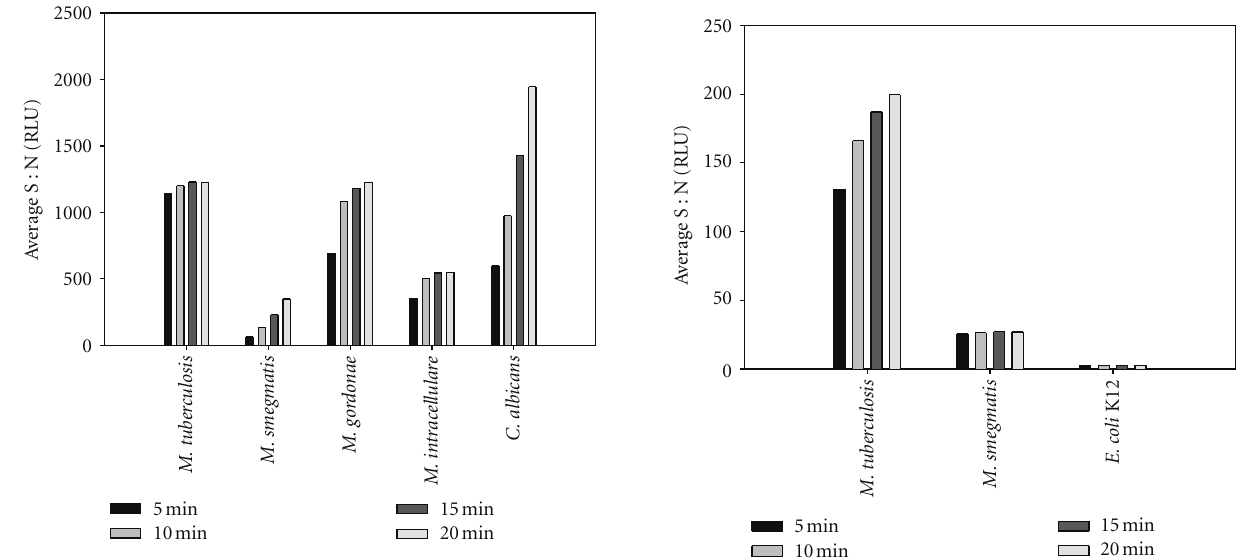
Figure 2: Standard ATP assay results for various mycobacteria and Candida albicans at approximately 10 6 CFU/ml. Organisms were suspended and serially diluted in Mueller Hinton II broth containing 0.1% Tween-80 and evaluated using the BacTiter-Glo basic ATP assay.